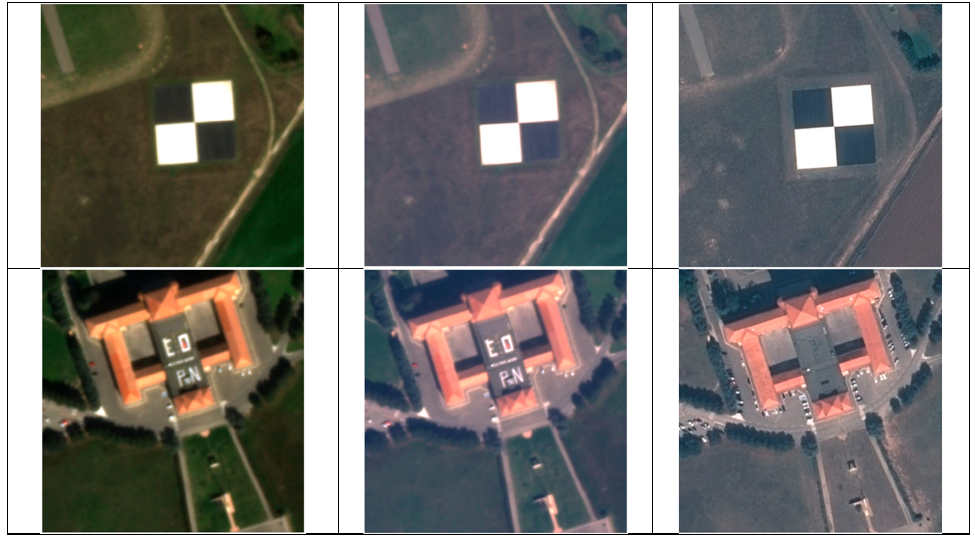
Figure 12. Examples of parts of images from SkySat RGB ( left ), pan-sharpened RGB ( middle ), and Pleiades ( right ), used for visual inspection.